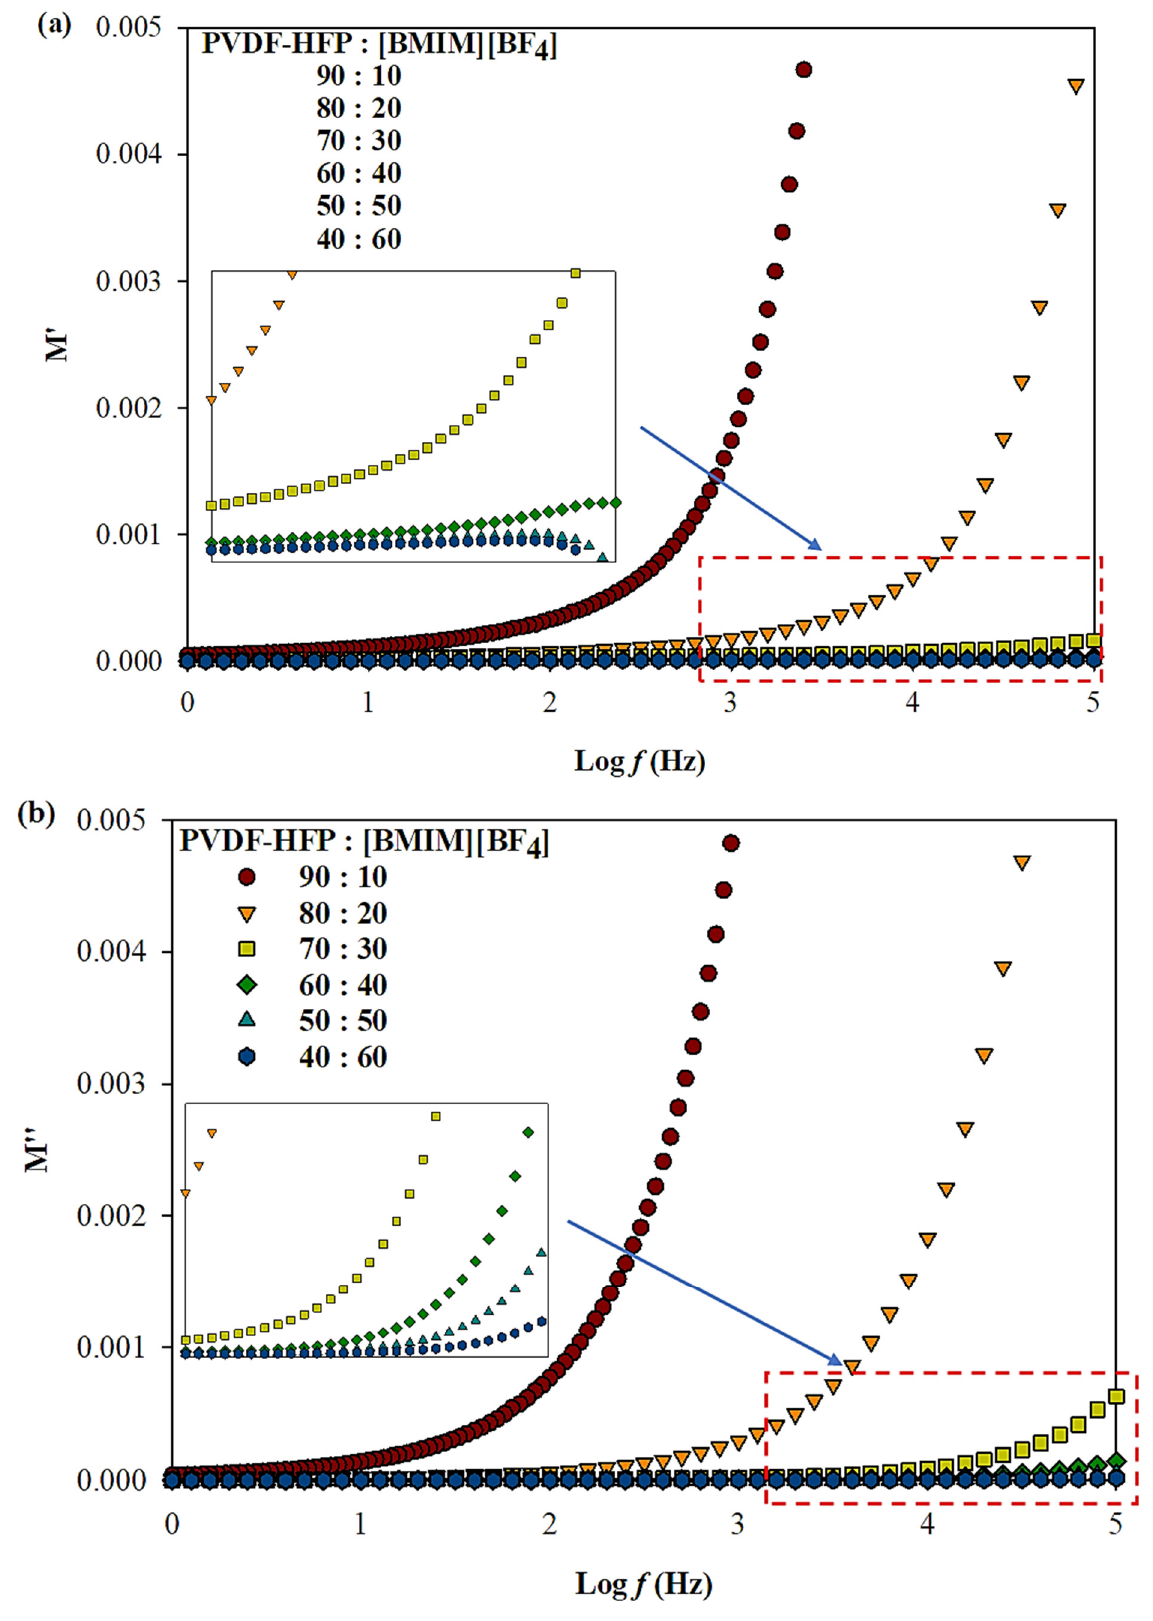
Figure 4. Frequency dependence of ( a ) real part and ( b ) imaginary part of modulus spectra for different percentage ratio of PVDF-HFP to [BMIM][BF 4 ] at room temperature.